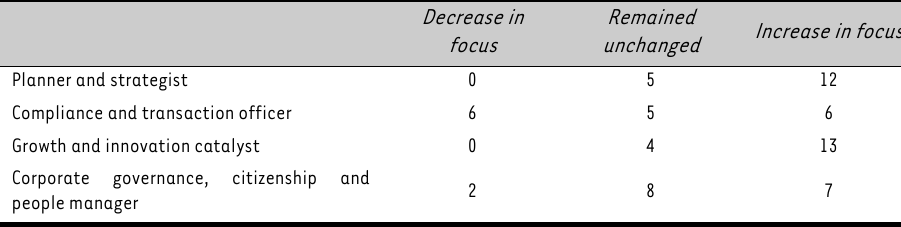
Decrease in Remained Increase in focus focus unchanged